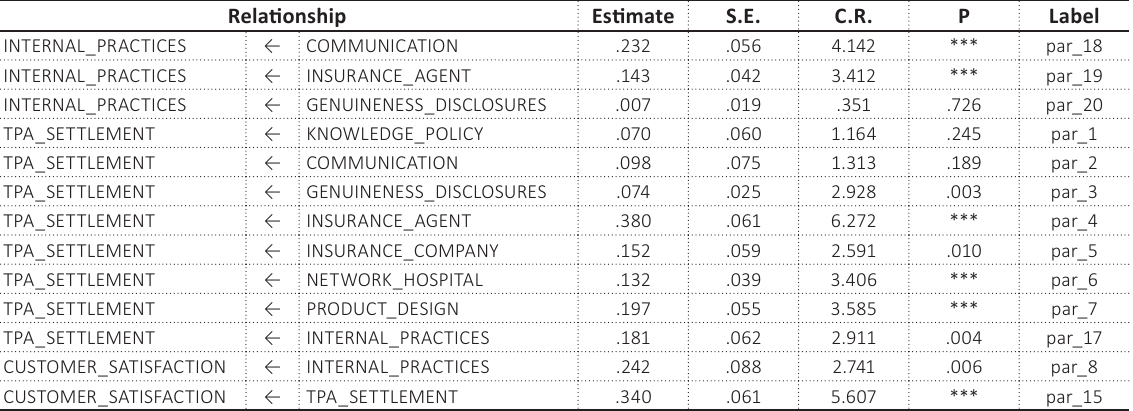
Table 5. Regression weights Relationship Estimate